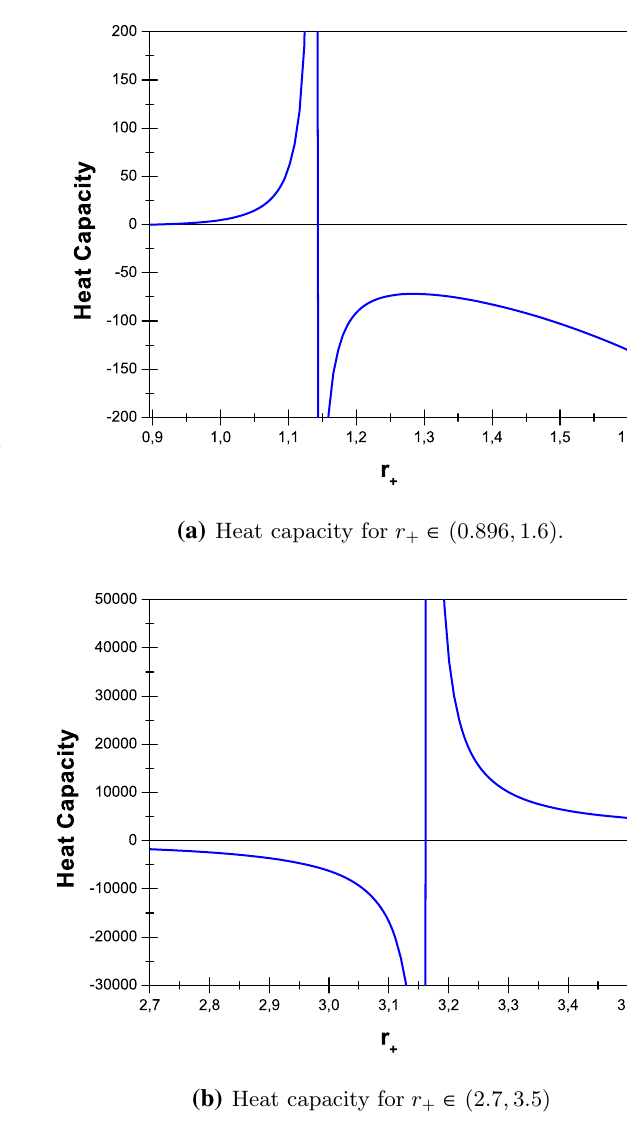
Fig. 5 Behavior of heat capacity for n = 3 and d = 10 with Q = 1, Fig. 4 Behavior of heat capacity for n = 3 and d = 10 with Q = 1 p = 0 , 00001 < p • For the p < p ( d T / d r + ) can c case, the derivative